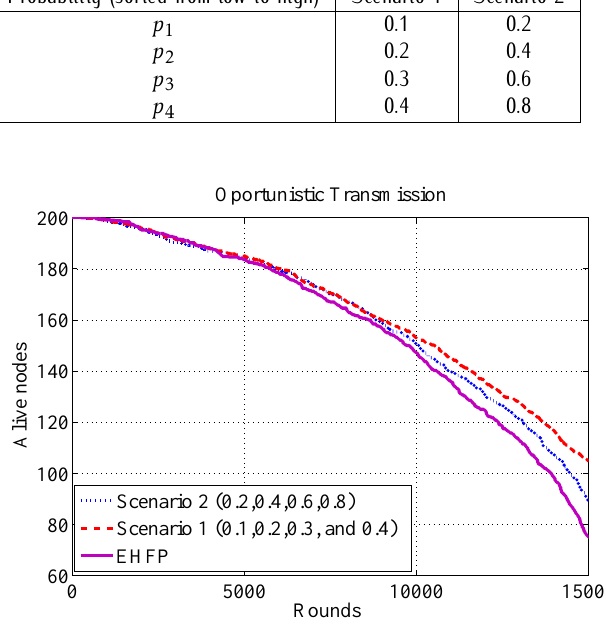
Figure 16. EHFP with different opportunistic transmission